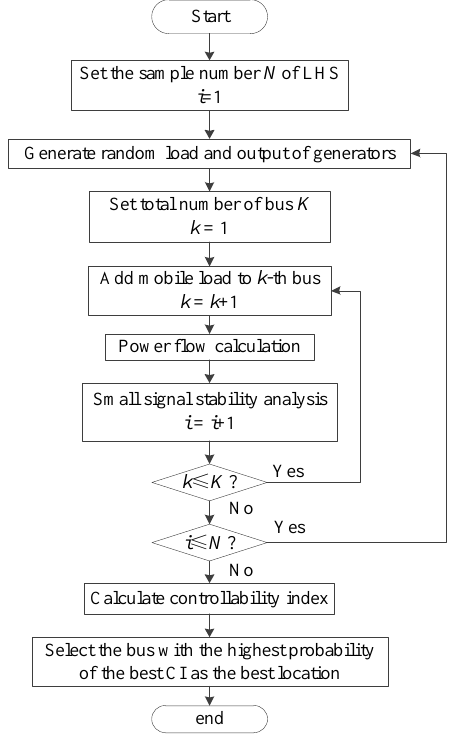
Figure 2. Flow chart of proposed method.